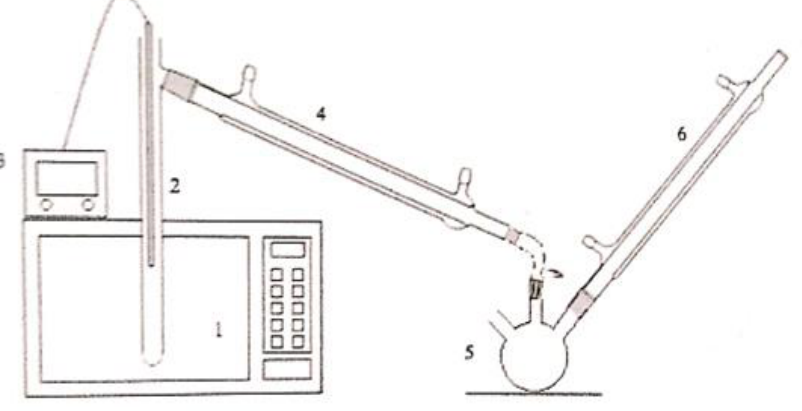
Figure 1(a): Schematic of modified microwave-assisted experimental set up for hydrothermal liquefaction process. (1) Microwave oven, (2) Quartz reactor, (3) Digital Multimeter and thermocouple, (4&6) Liebig condenser (5) Necks collecting